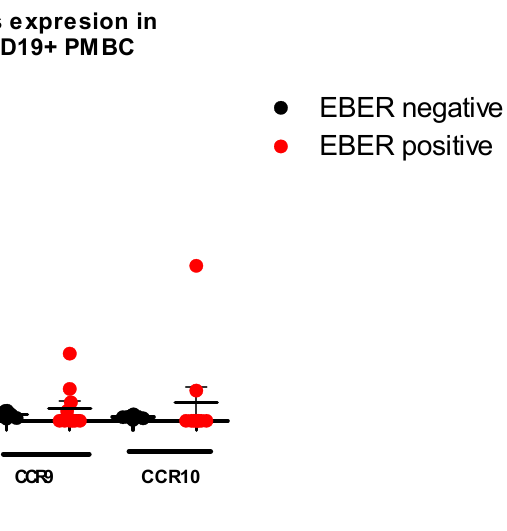
Fig. 5. The expression of chemokine receptors on B cell relative to EBV infection. 10